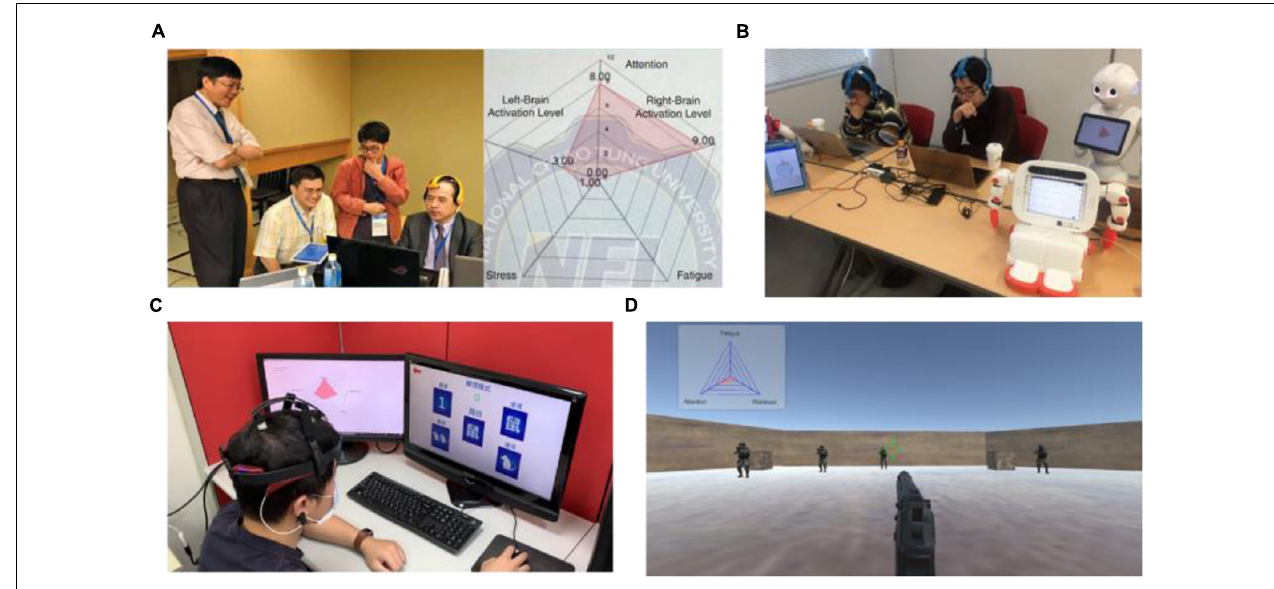
FIGURE 9 | Real-world applications of the proposed physiological states indicator. (A) A Go player using the system while playing Go with smart machines for machine-human co-learning. (B) Intelligent agent for robotic edutainment in mathematical and language learning. (C) Game-based assessment of cognitive functions. (D) Training of soldiers using first person shooting